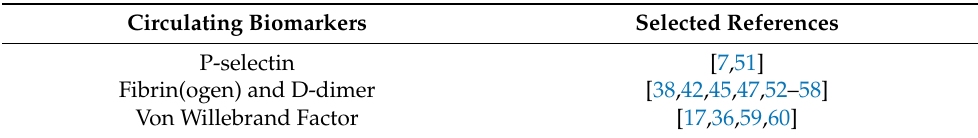
Table 1. Dysregulation of circulating biomarkers P-selectin, von Willebrand Factor, fibrin(ogen) and D-dimer in COVID-19. See Figure 1 for levels during